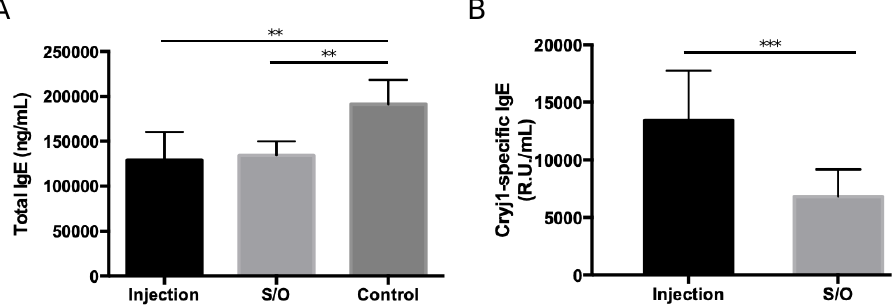
Figure 6. Serum antibody responses after immunotherapy using PE-GM in a pollinosis mouse model. PE-GM in S / O nanodispersions (S / O) and PE-GM PBS solution (Injection) were administrated once a week for three weeks, and ( A ) total immunoglobulin E (IgE) and ( B ) Cry j 1-specific IgE levels in the mice were measured by ELISA. n = 9, mean ± SE. ** p < 0.01, *** p < 0.001.